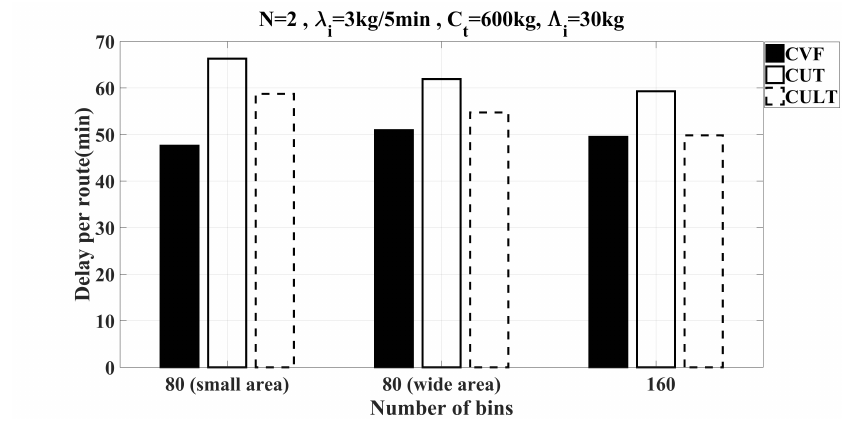
Figure 21. Delay per route: bin count as the number of bins